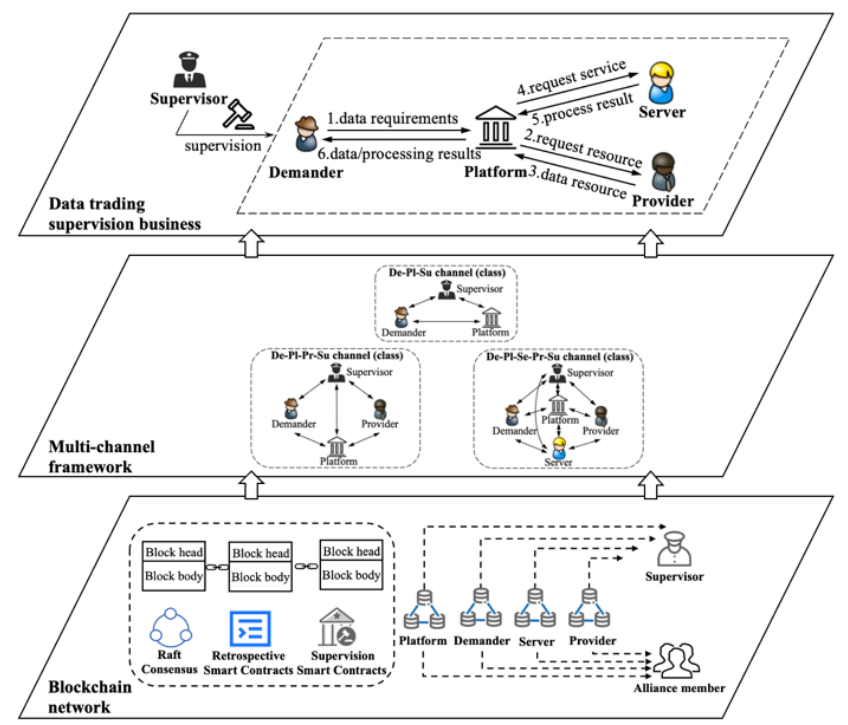
Figure 4. Blockchain-based distributed supervision model for data trading.